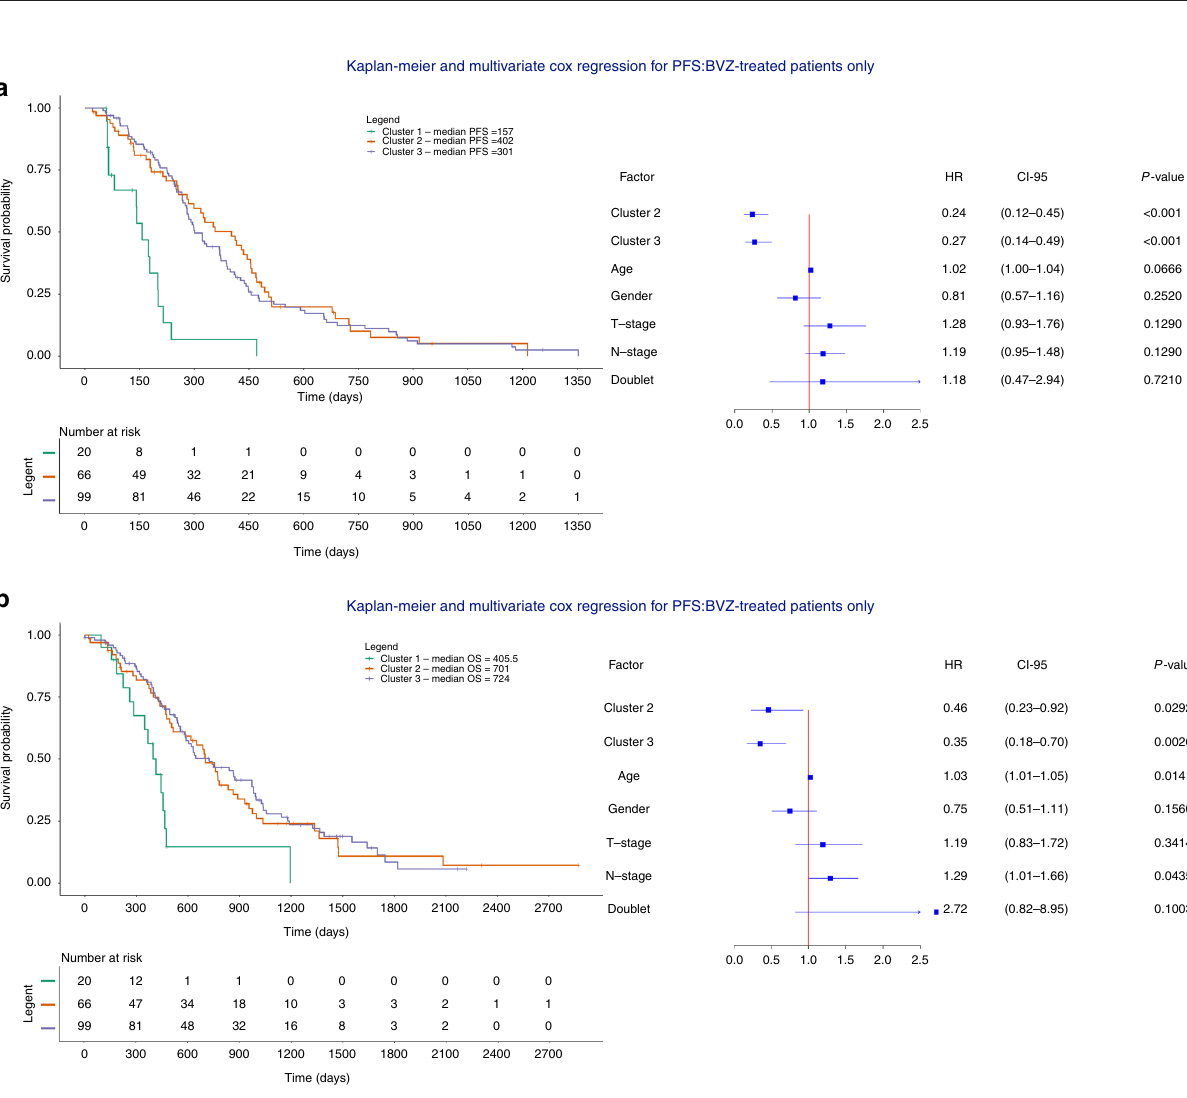
Fig. 2 Multivariate Cox regression and clinical characteristics of CNA clusters. a Kaplan-Meier plots and multivariate Cox regression with hazard ratios, 95% con fi dence intervals and P-values for CNA clusters are shown while correcting for the relevant covariates in all ( n = 908) CRC samples. Cluster 1 is considered a reference. There is no difference for cluster identity, instead T-stage, N-stage, and M-stage are signi fi cant covariates in the model. b Clinical characterization of the CNA clusters. Clusters 2 and 3 are enriched for tumors with high T-stage, N-stage, and M-stage. Chi-squared P-values are presented between parentheses. c , d Kaplan-Meier plots and multivariate Cox regression with hazard ratios, 95% con fi dence intervals and P-values for CNA clusters are shown while correcting for the relevant covariates in mCRC samples treated ± BVZ ( n = 409). Cluster 1 is considered a reference. Doublet stands for mono-chemotherapy (FP) or a combination of chemotherapy (FP-OX, FP-IRI). Clusters 2 and 3 are correlated with better PFS and OS independent of the other covariates